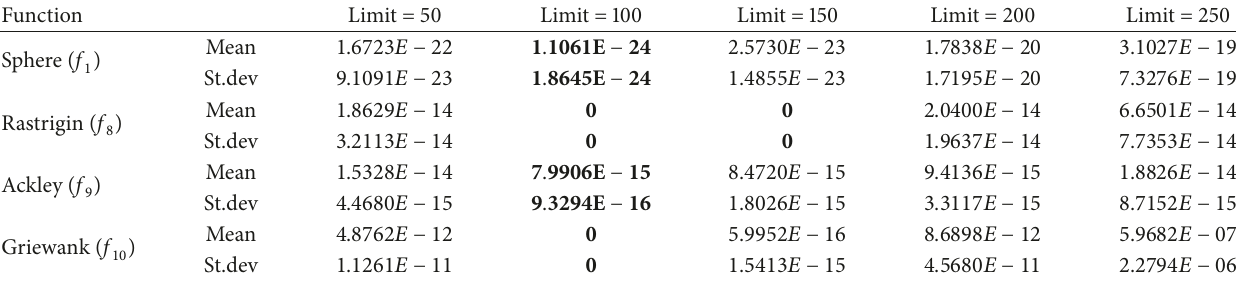
Table 5: The experimental results of SABC with different limit